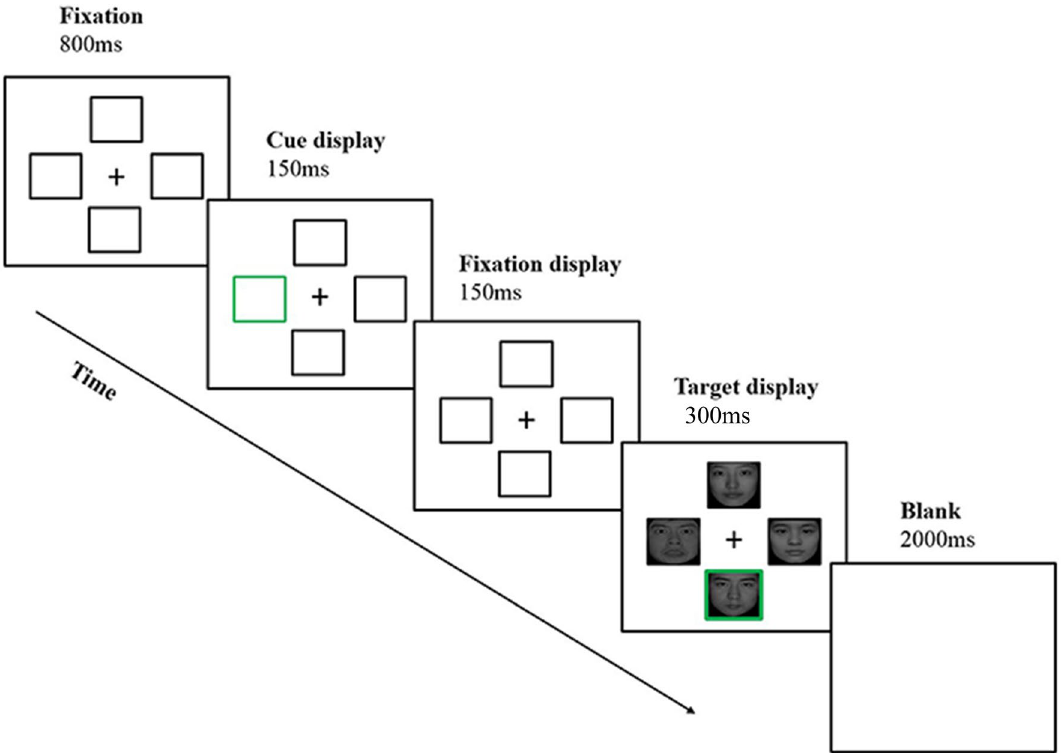
Figure 5. The modified spatial cueing task. A trial in the modified spatial cueing task consisted of the following display sequences: fixation display, cue display, fixation display, target display, and blank screen. The depicted trial represents a fearful face in the strong top-down